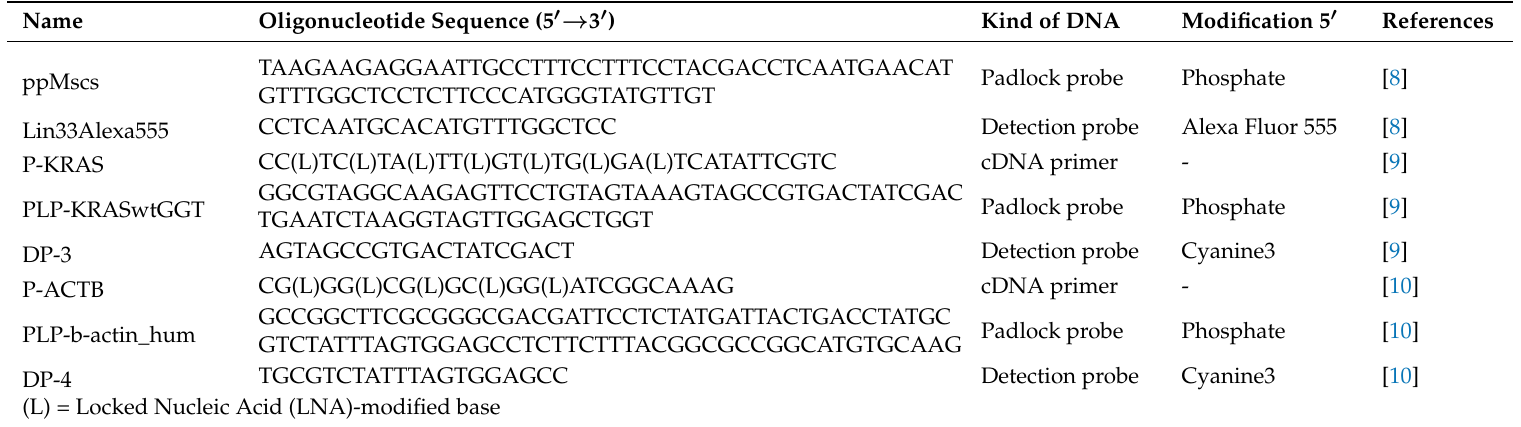
Table 1. Oligonucleotide